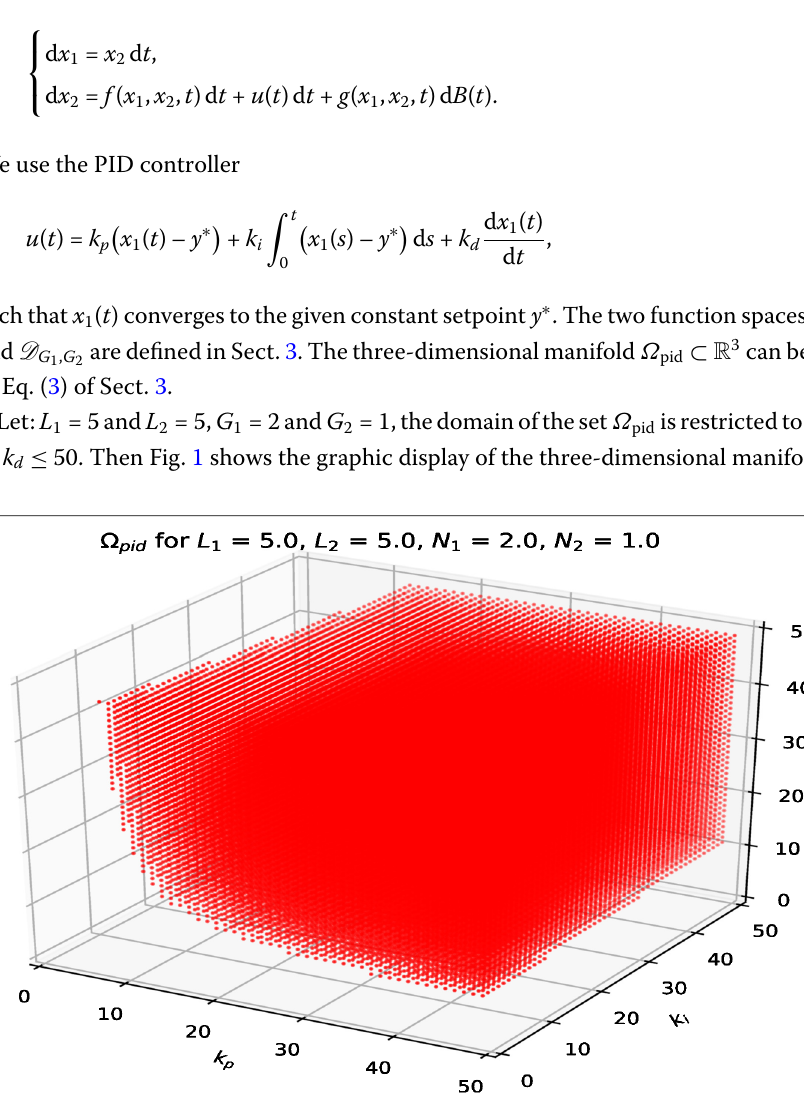
Figure 1 Graphic display of the three-dimensional